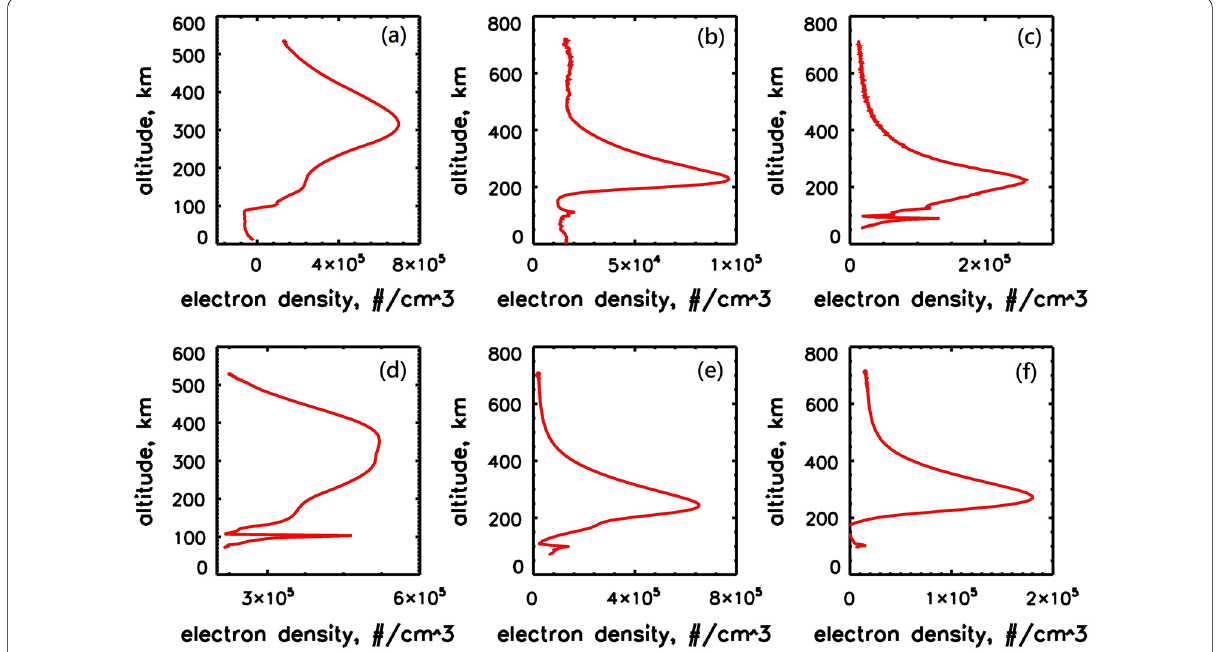
Fig. 3 Six examples of electron density profiles from F7/C2 TGRS retrieved from TROPS. The information was recorded in: a ionPrf_